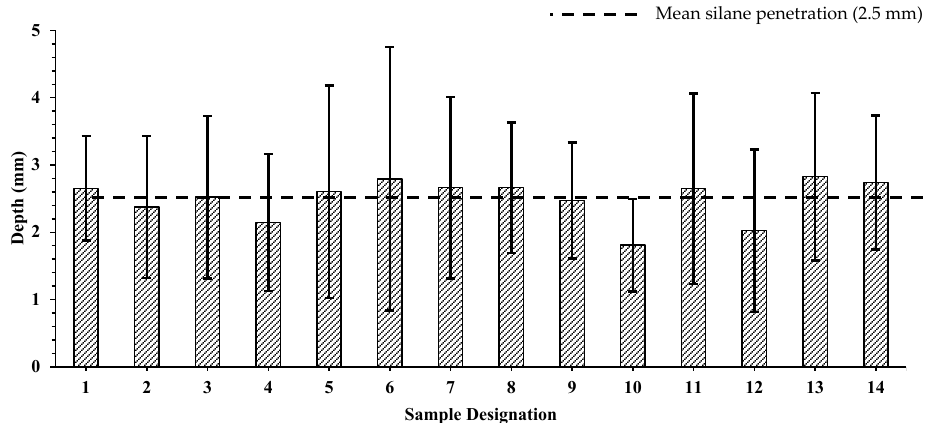
Figure 5. Average depth of silane penetration for all samples.